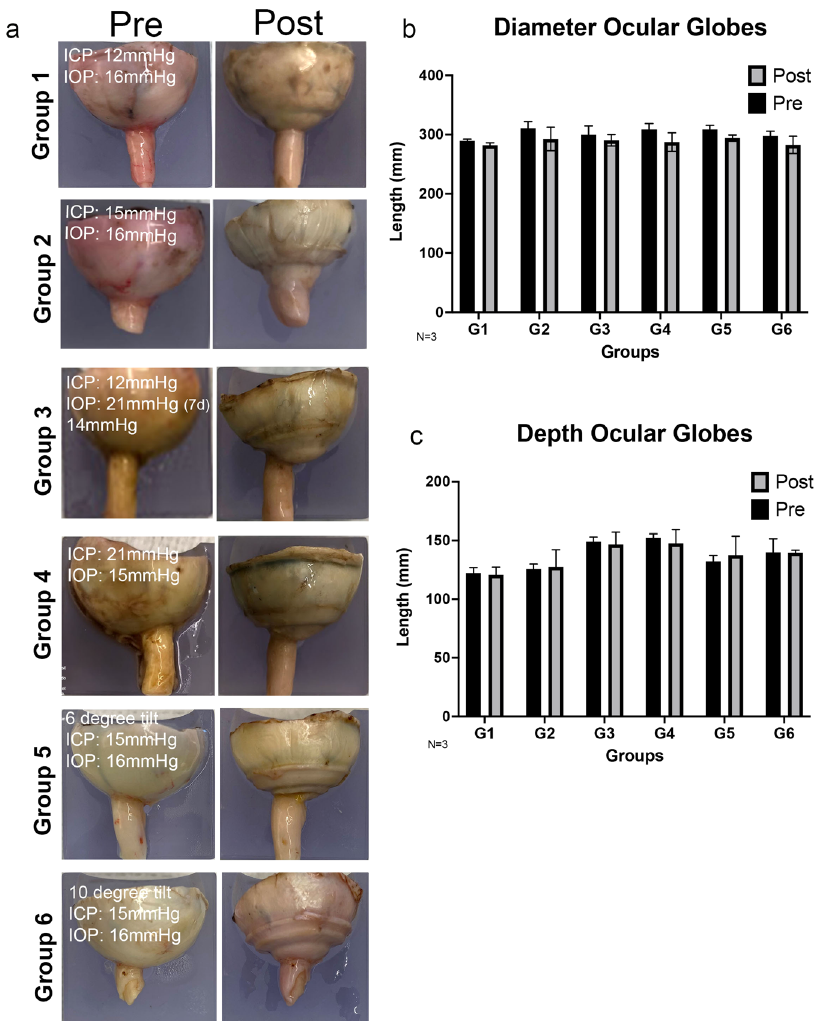
Fig. 2 Analysis of posterior human globes pre and post culture in the TAS model. a Representative images of posterior globes pre and post 14 days perfusion culture. Graphical representation of pre-post values of ( b ) diameter and ( c ) depth of posterior globes ( N = 3). Length in pixels calculated from Adobe Photoshop. ICP intracranial pressure, IOP intraocular pressure. Data are presented as mean ± standard error of the mean and P < 0.05 was considered statistically signi fi